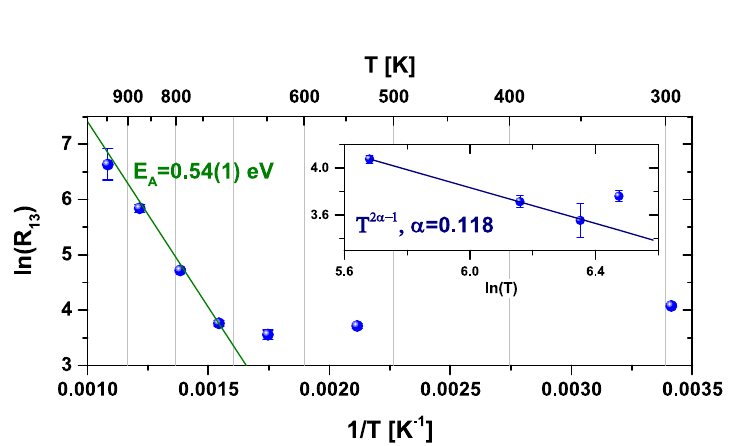
Figure 3. Arrhenius plot of the transition rate R 1 → 3 (MHz) as a function of temperature in logarithmic scale and the corresponding fit between 648 K and 923 K. (inset) Logarithmic R 1 → 3 plotted as a function of logarithmic temperatures between 293 K and 573 K. The linear curve corresponds to T slope of the curve is equal to 2 α − 1